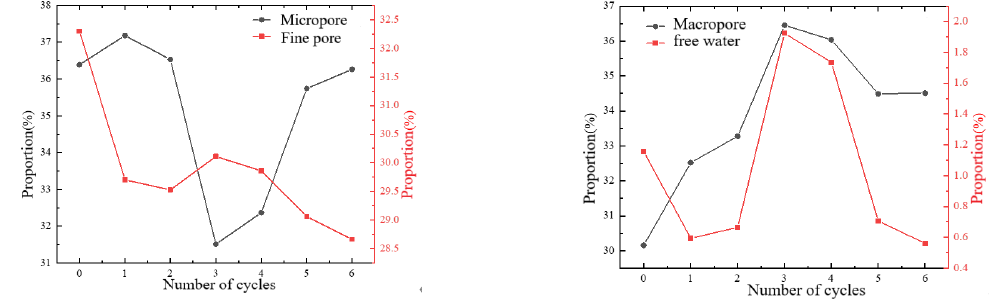
Figure 5. Evolution of the proportion of micro-, fine, and large pores, as well as free water, before and after freeze–thaw cycles .